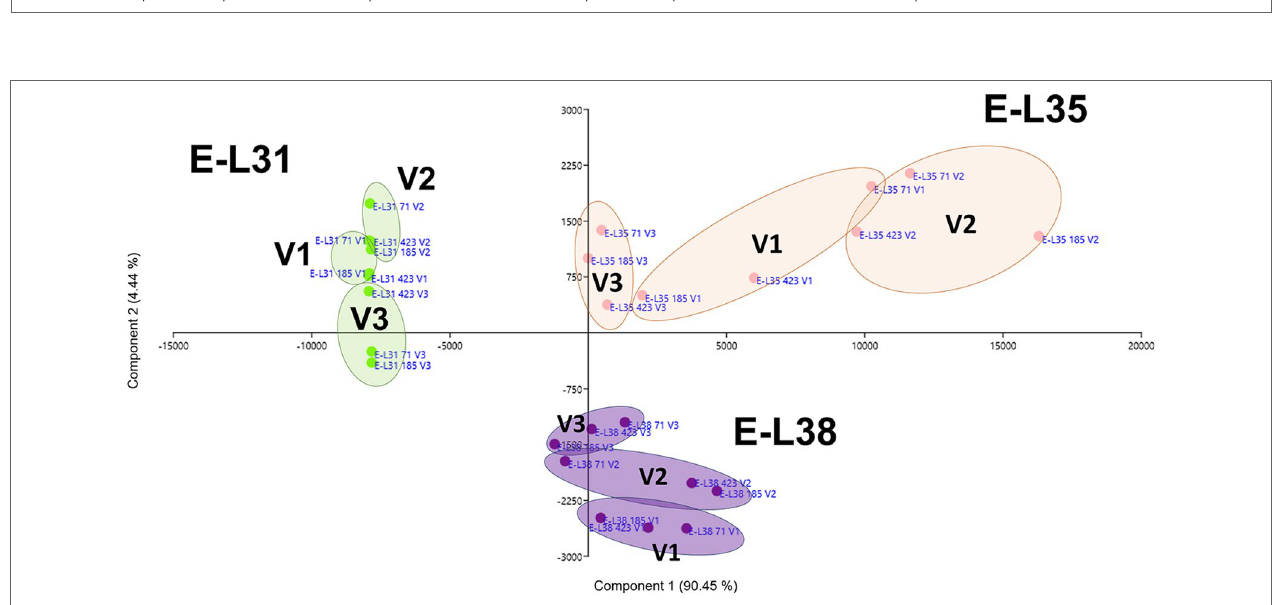
FIGURE 3 | Environmental effect on carbohydrate metabolism. Schematic representation highlighting how the three considered variables, ripening stage (E-L31, E-L35, E-L38), clone (CVT71, CVT423, CVT185), or vineyard (V1, V2, V3), affect the distribution of samples when genes belonging to Carbohydrate metabolic process were analyzed by principal component analysis (PCA). Conversion between the modified E-L scheme and the extended BBCH scheme is as it follows, E-L31 = 75 BBCH; E-L35 = 81 BBCH; E-L38 = 89 BBCH.